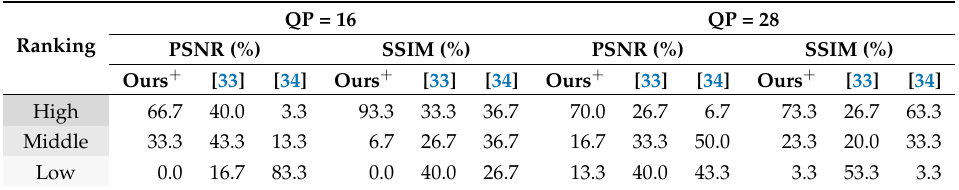
Table 5. The percentages of PSNR and SSIM values of different schemes using the ( 0,0 ) coefficient pairs in each